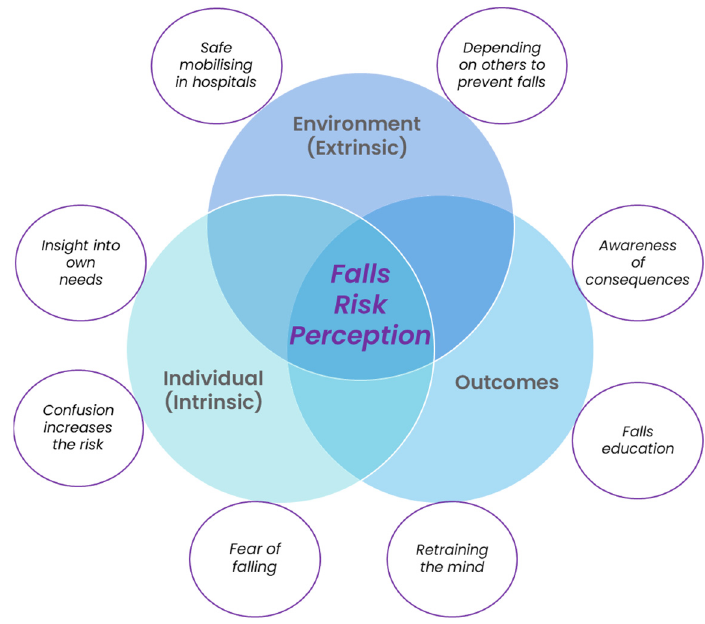
Figure 1. Thematic Model.